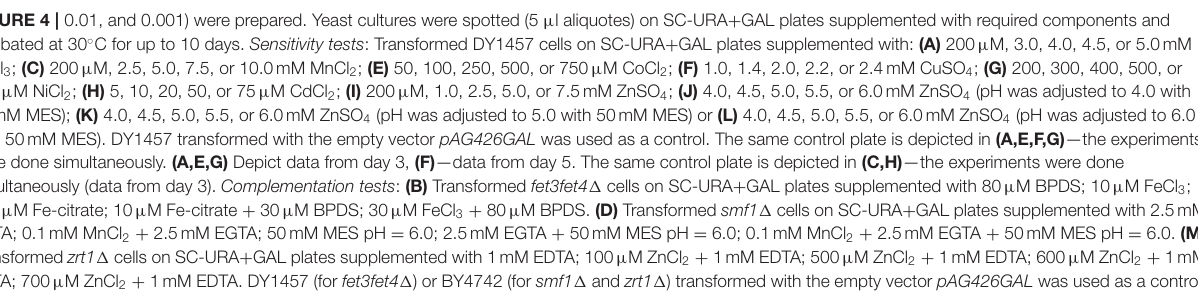
FIGURE 4 | 0.01, and 0.001) were prepared. Yeast cultures were spotted (5 µ l aliquotes) on SC-URA + GAL plates supplemented with required components and incubated at 30 ◦ C for up to 10 days. Sensitivity tests : Transformed DY1457 cells on SC-URA + GAL plates supplemented with: (A) 200 µ M, 3.0, 4.0, 4.5, or 5.0mM FeCl 3 ; (C) 200 µ M, 2.5, 5.0, 7.5, or 10.0mM MnCl 2 ; (E) 50, 100, 250, 500, or 750 µ M CoCl 2 ; (F) 1.0, 1.4, 2.0, 2.2, or 2.4mM CuSO 4 ; (G) 200, 300, 400, 500, or 600 µ M NiCl 2 ; (H) 5, 10, 20, 50, or 75 µ M CdCl 2 ; (I) 200 µ M, 1.0, 2.5, 5.0, or 7.5mM ZnSO 4 ; (J) 4.0, 4.5, 5.0, 5.5, or 6.0mM ZnSO 4 (pH was adjusted to 4.0 with 50mM MES); (K) 4.0, 4.5, 5.0, 5.5, or 6.0mM ZnSO 4 (pH was adjusted to 5.0 with 50mM MES) or (L) 4.0, 4.5, 5.0, 5.5, or 6.0mM ZnSO 4 (pH was adjusted to 6.0 with 50mM MES). DY1457 transformed with the empty vector pAG426GAL was used as a control. The same control plate is depicted in (A,E,F,G) —the experiments were done simultaneously. (A,E,G) Depict data from day 3, (F) —data from day 5. The same control plate is depicted in (C,H) —the experiments were done simultaneously (data from day 3). Complementation tests : (B) Transformed fet3fet4 1 cells on SC-URA + GAL plates supplemented with 80 µ M BPDS; 10 µ M FeCl 3 ; 100 µ M Fe-citrate; 10 µ M Fe-citrate + 30 µ M BPDS; 30 µ M FeCl 3 + 80 µ M BPDS. (D) Transformed smf1 1 cells on SC-URA + GAL plates supplemented with 2.5mM